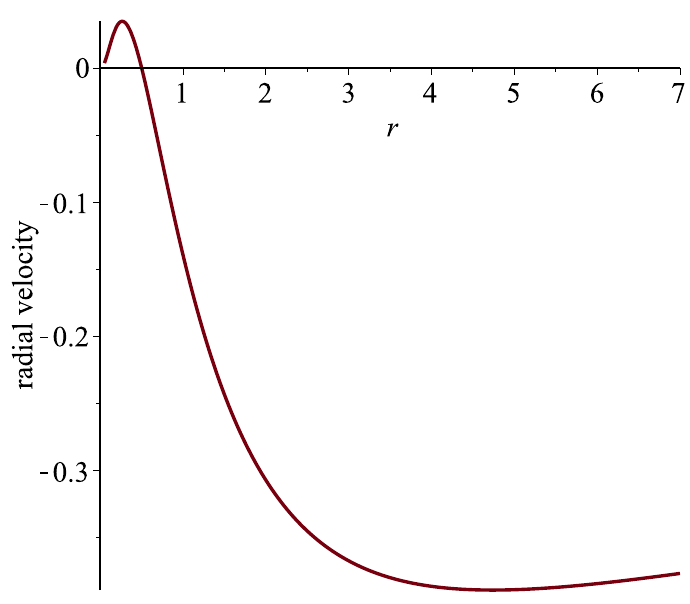
Figure 5. Behaviour of ˙ r in the Schwarzschild geometry using isotropic coordinates for m = 1 and (cid:101) = 1. Note the coordinate velocity is negative all the way from the horizon (now at m /2) to spatial